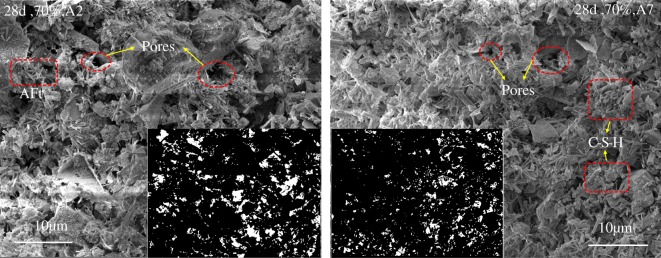
Magnified SEM image.